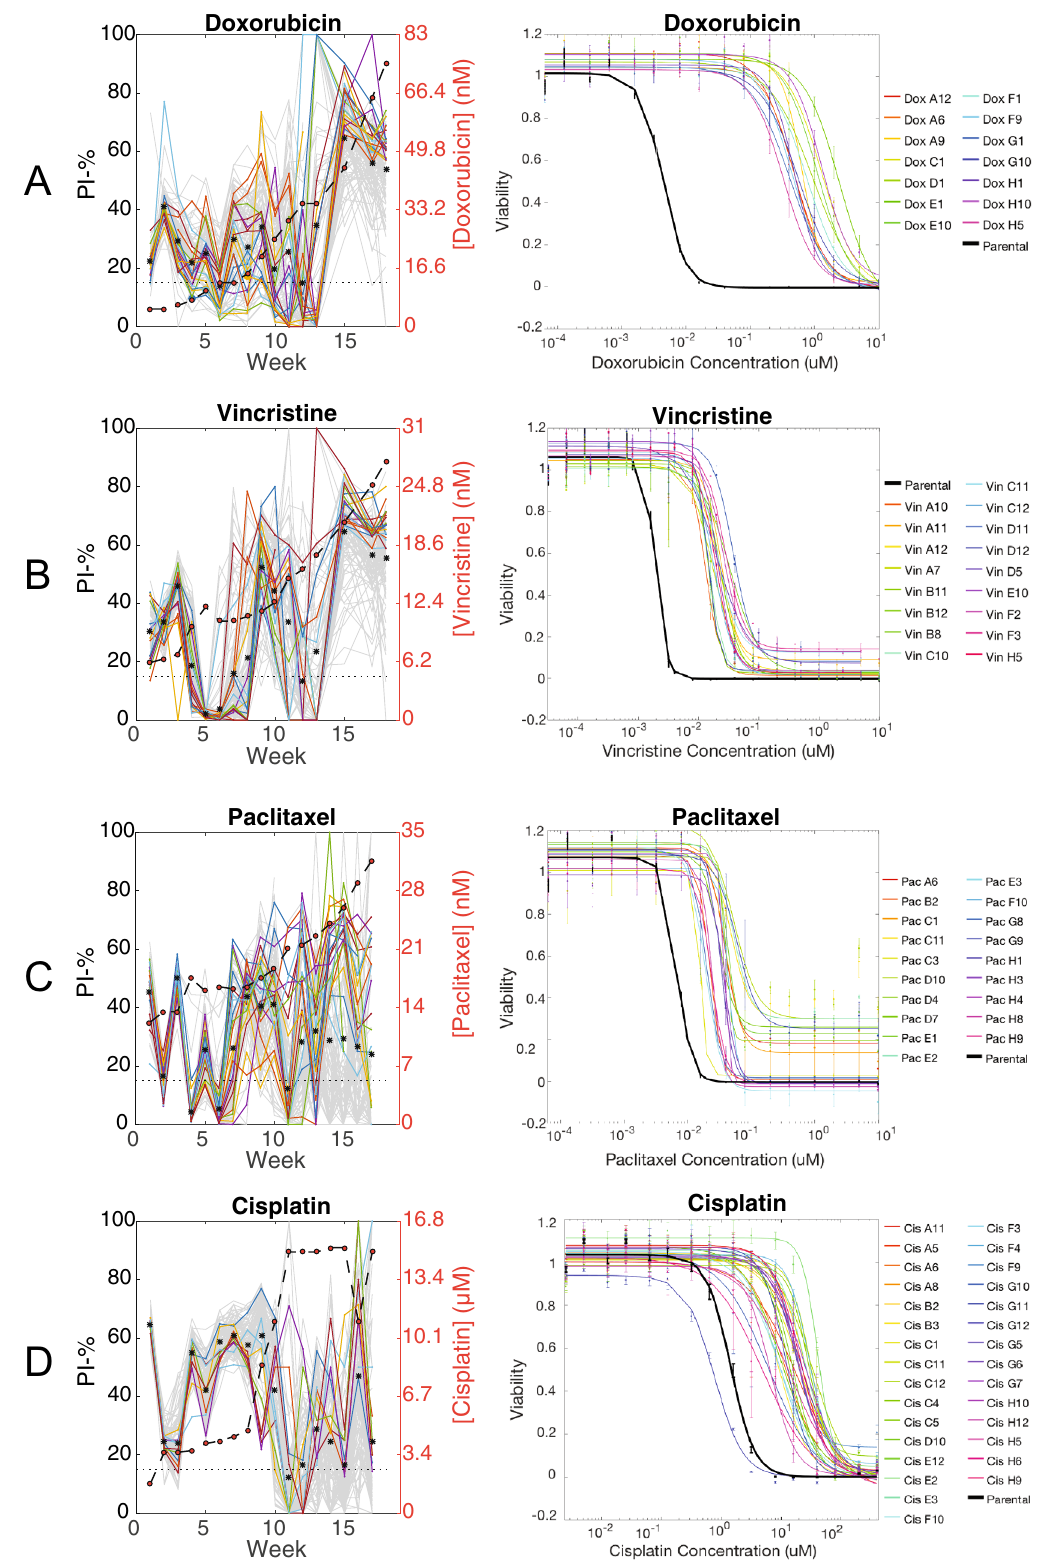
Figure 3. Viability of cell lines over each cycle of the resistance evolution experiment (left column) and quantification of sensitivity to the selection drug after 18 cycles (right column). In the left column, colored lines represent wells that were most viable over the last 5 weeks of the experiment. Each row represents acquired resistance to (A) doxorubicin, (B) vincristine, (C) paclitaxel, and (D)